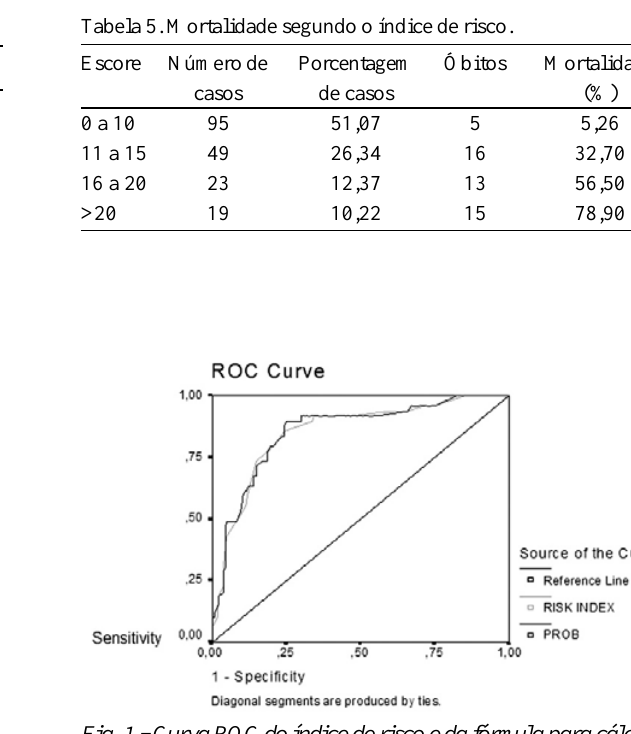
Fig. 1 - Curva ROC do índice de risco e da fórmula para cálculo da probabilidade de